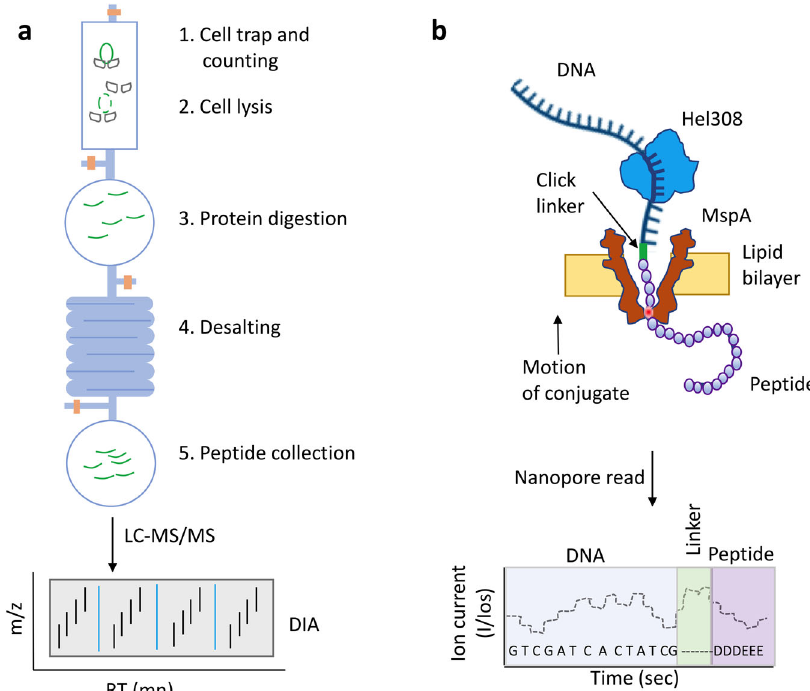
Fig. 1 Single-cell proteomics methods. a Schematic of a single unit of a single-cell integrated proteomics chip (SciProChip) and streamlined work fl ow for nano-proteomics used by Gebreyesus et al. b A nanopore device used by Brinkerhoff et al. to read DNA – protein conjugates with single amino acid